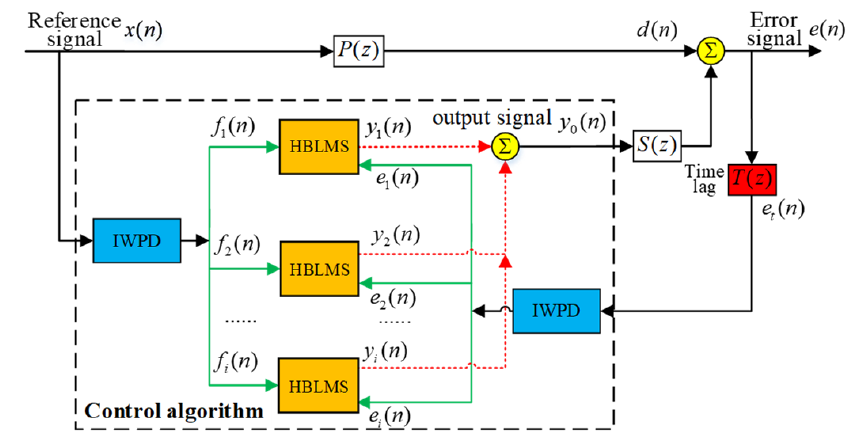
Figure 8. Schematic structure of IWPHB-FxLMS algorithm.